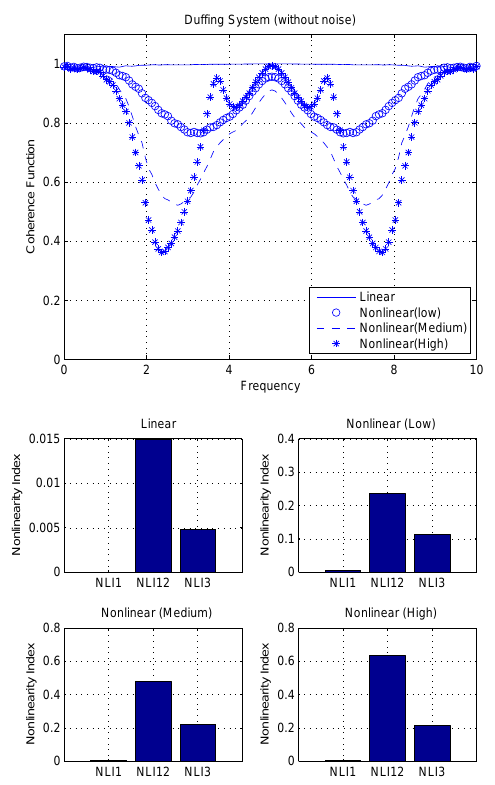
Figure 3: Top. Coherence function of Duffing sys- tem in linear and nonlinear modes with non- periodic excitation signal. Bottom. Non- linearity measures NLI1, NLI2, NLI3 for Duffing system with non-periodic excitation